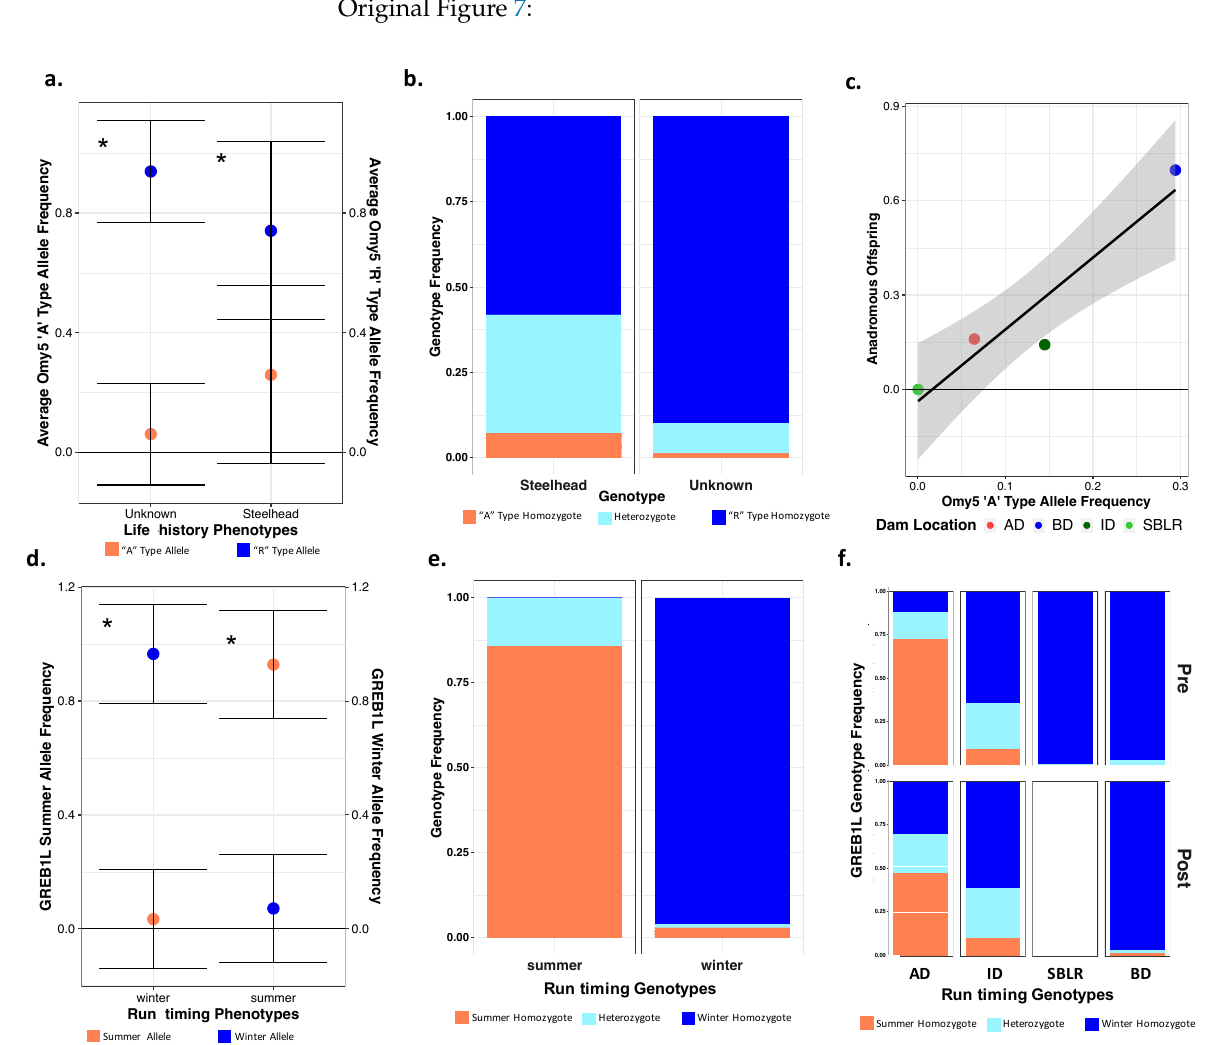
Figure 7. There were significant differences in the allelic and genotypic frequencies of the Omy5 ( a – c ) and the GREB1L variants ( d – f ) among populations and life histories. There were significant differences in the mean allele frequencies of the Omy5 locus allele frequencies between steelhead and unknown forms ( a ) and the frequency of the Omy5 “A” type allele frequency significantly explained life history phenotype ( b ). We also observed a strong correlation between the number of anadromous individuals from each population and the frequency of the “A” allele ( c ). The mean frequency of the GREB1L summer allele also varied significantly between summer- and winter-run steelhead ( d ), with the frequency of the homozygous summer genotype significantly explaining run timing ( e ), and inferred, ancestral population explaining a significant proportion of the variation in genotype both prior to and post-dam removal ( f ). Asterisks ( a , c ) indicate statistical significance ( α = 0.01)